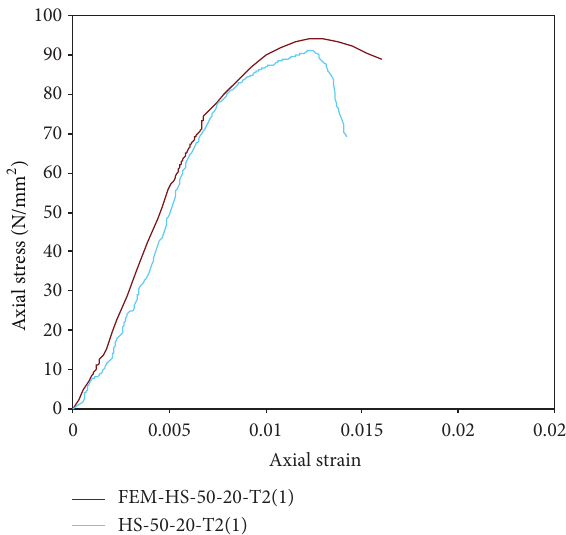
Figure 31: Comparison of experimental and computed axial stress-strain behaviours of HS-50-20-T2 (1) columns.